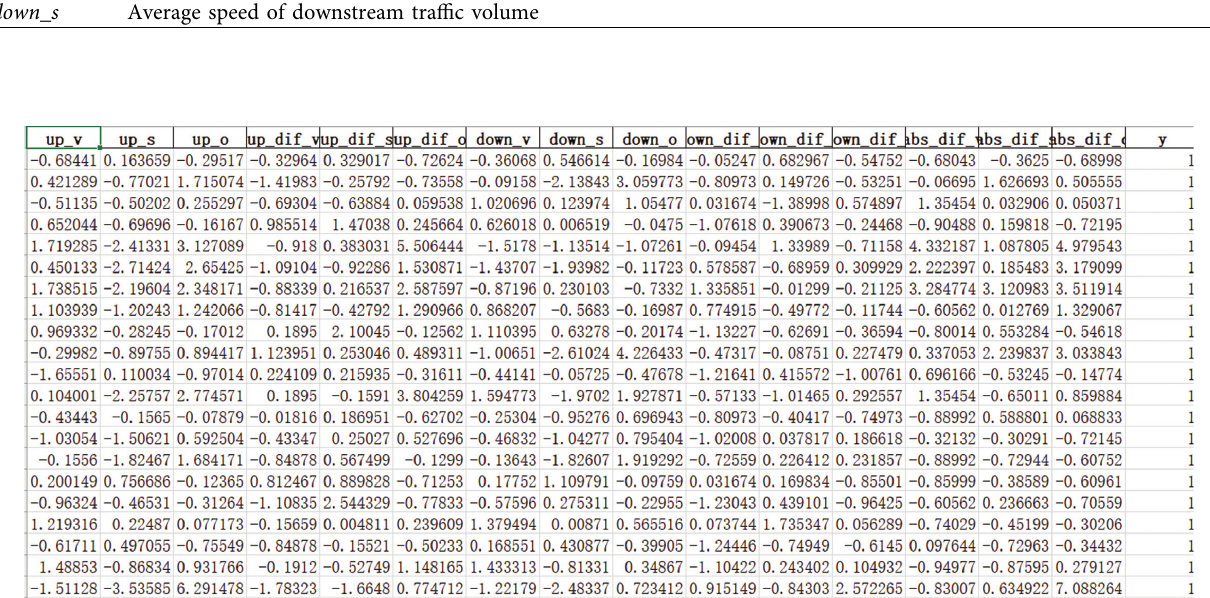
Figure 3: High precision data set sample.